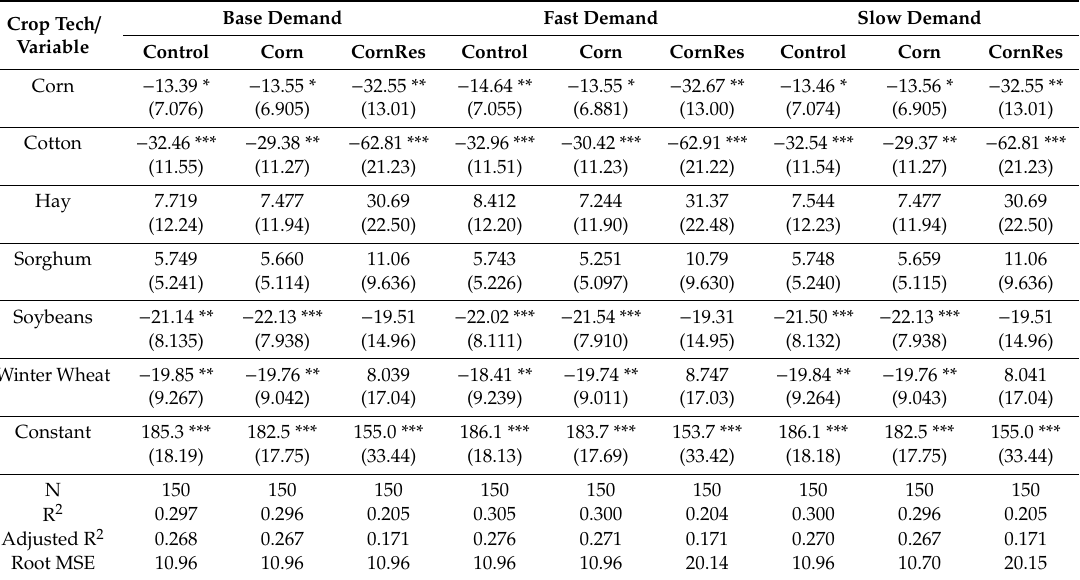
Table 7. Biofuel production land regression